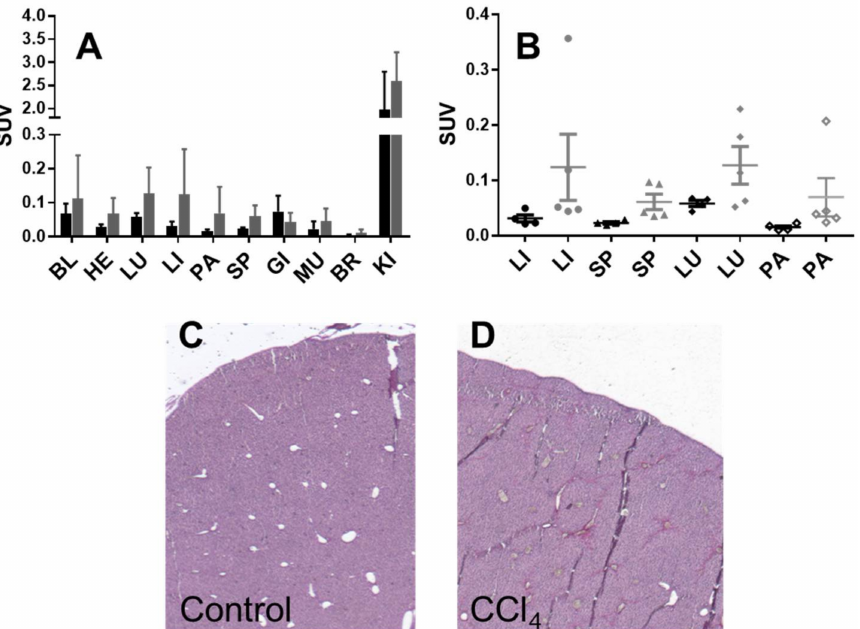
Figure 3. Organ distribution of 68 Ga]Ga-NO2A-[Nle13]-Col in healthy mice (black bars ( A ) and points ( B )) and mice with induced liver fibrosis (grey bars ( A ) and points ( B )). BL: blood; HE: heart; LU: lungs; LI: liver; PA: pancreas; SP: spleen; MU: muscle; BM: red bone marrow; BR: brain; KI: kidneys. Representative Sirius Red staining images (4x magnification) of liver sections from mice with CCl 4 -induced fibrosis ( C ) and healthy controls ( D ).